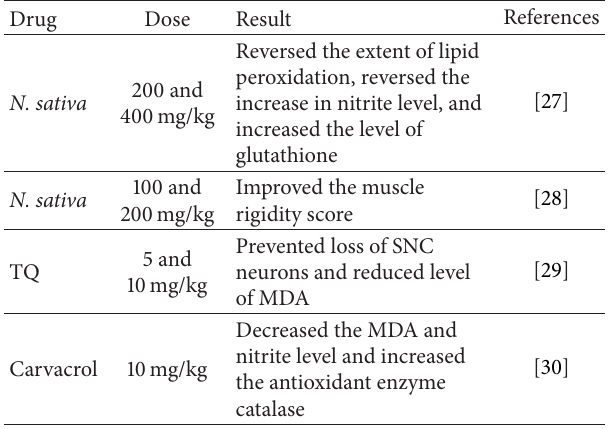
Table 4: The protective effect of Nigella sativa and its constituents on Parkinson’s